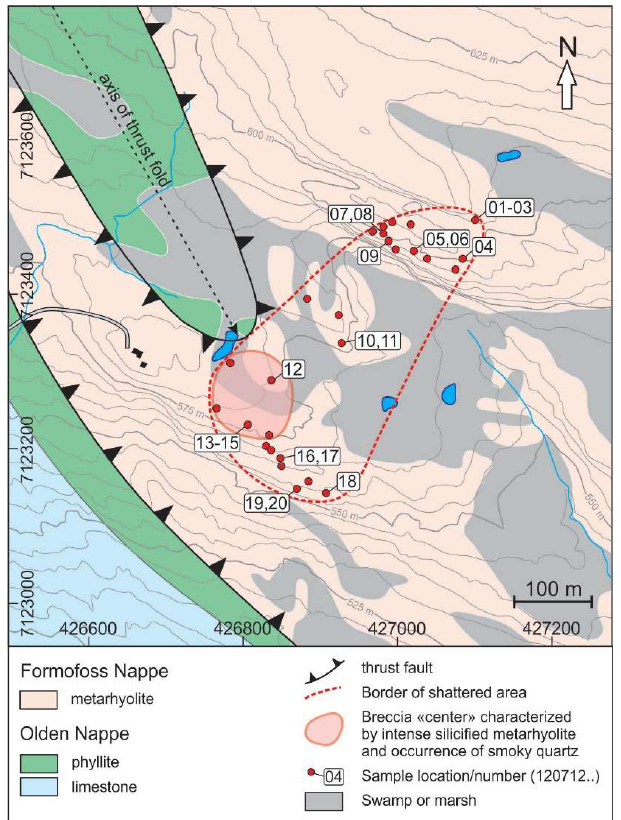
Figure 2. Local geological map of Berglia-Glassberget area according to Fossen et al. [20] with breccia extension and sample locations.